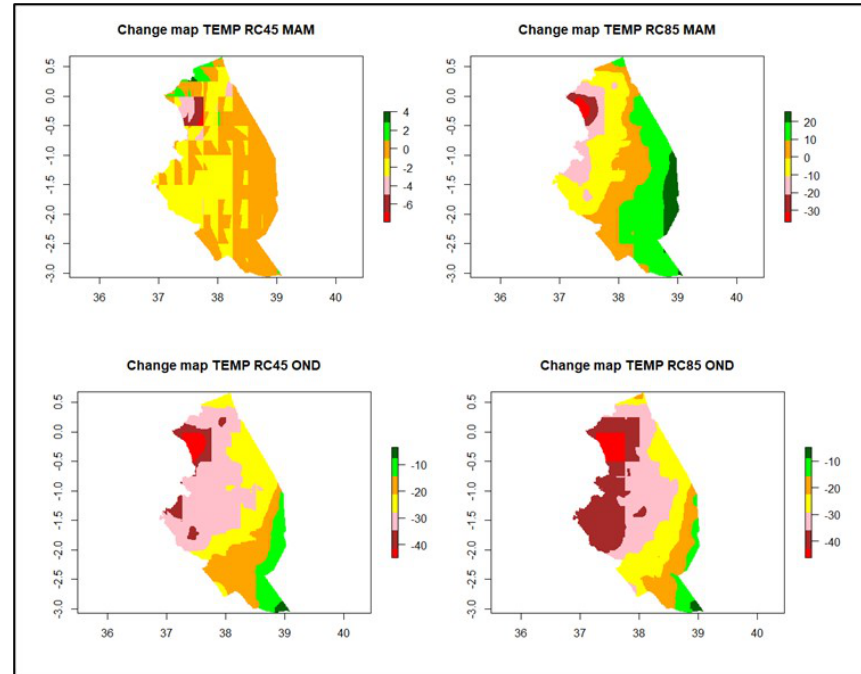
Figure 3. Thermal Regimes for MAM, OND in 2040 for RCPs 4.5 and